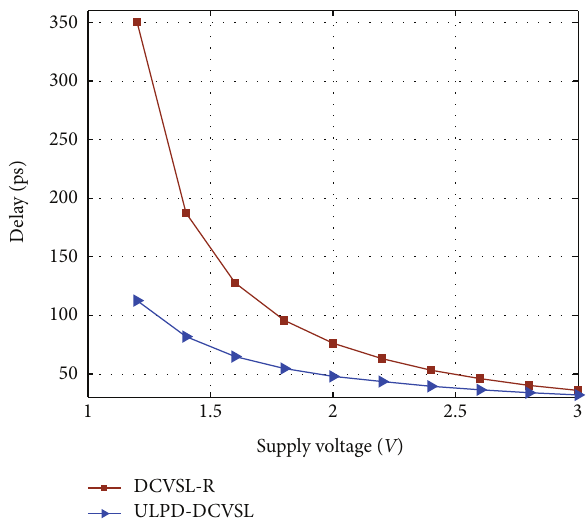
Figure 8: Delay versus supply voltage of ULPD-DCVSL and DCVSL-R